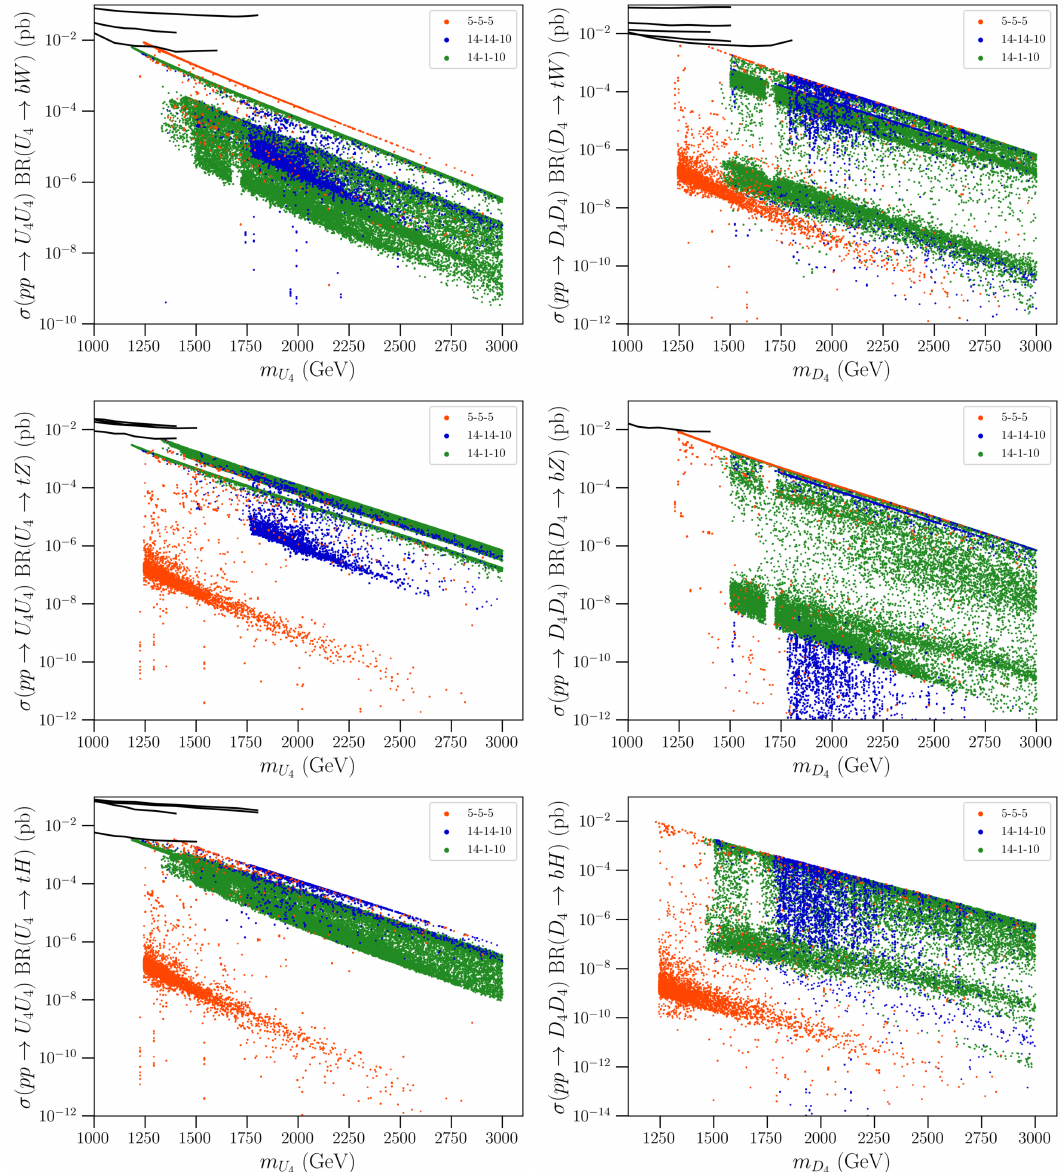
Figure 12. Cross sections for decays of the lightest up-type and down-type resonances U 4 and D 4 √ into SM final states at s = 13 TeV for valid points in each model. Black lines mark the 95 % CL upper bounds taken as